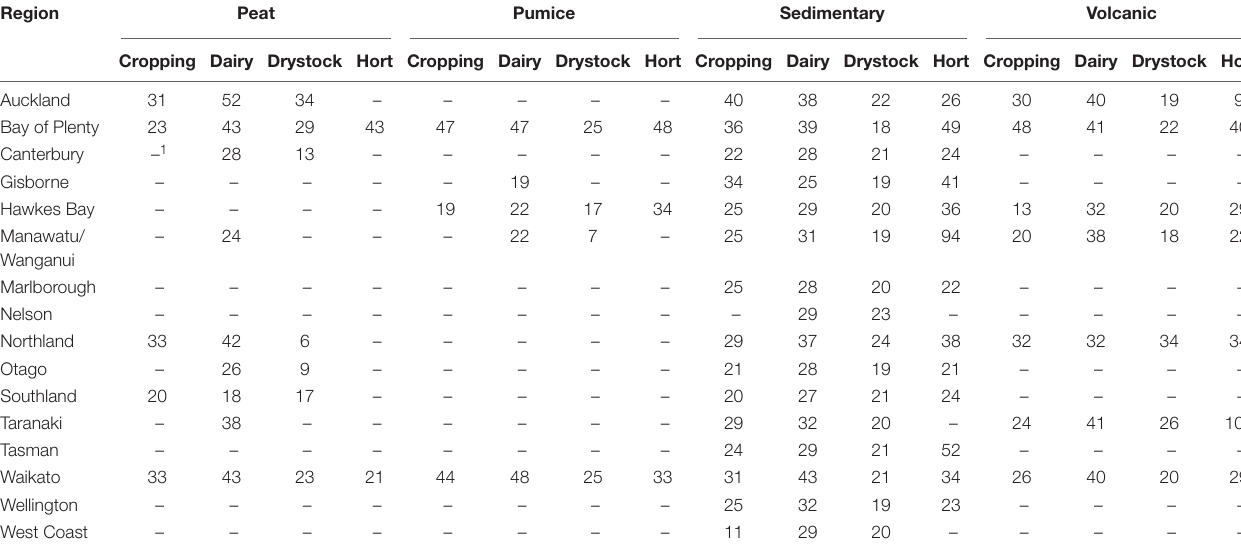
TABLE 1 | Median Olsen P concentrations (mg L − 1 ) in each region by soil group by land use (Hort = horticulture) combination. Region Peat Pumice Sedimentary